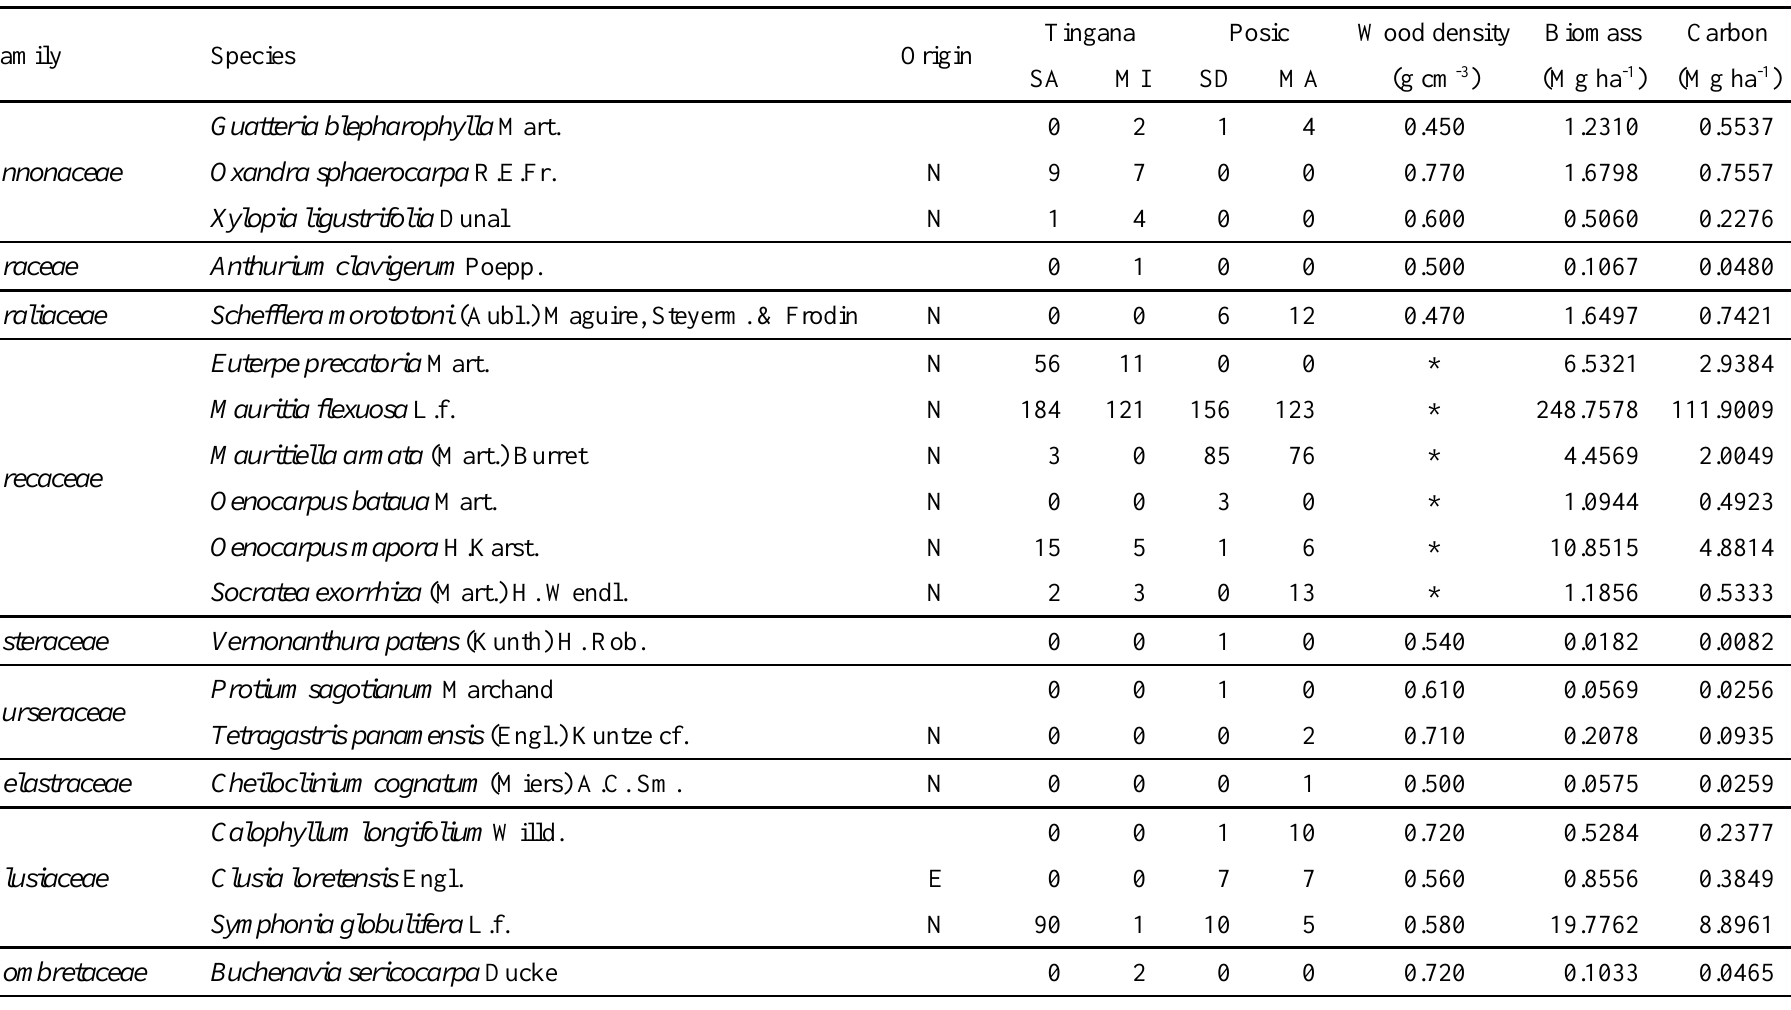
Table A1. List of species recorded, their conservation status, number of individuals, wood density (from Zanne et al. 2009), biomass and average carbon stocks in the four aguajales of M. flexuosa palm peat swamp forest in the Alto Mayo Valley (DBH ≥ 10 cm). Origin: N = Native, E = Endemic. Aguajales: Tingana (SA: Semi- dense aguajal, MI: Mixed-aguajal), Posic (SD: Semi-dense aguajal, MA: Mixed aguajal). * To estimate biomass of palms, we used the models proposed by Goodman et al. (2013) which do not require wood density